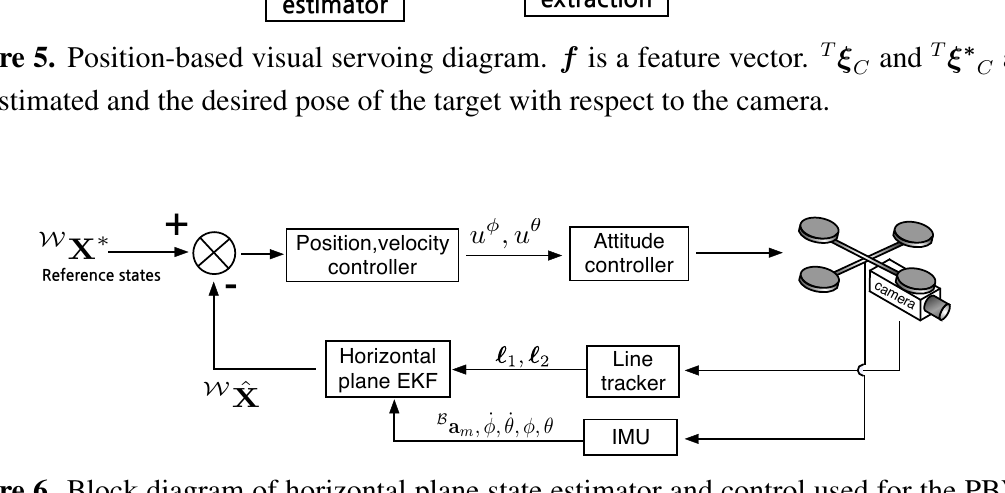
and (cid:96) are tracked 1 2